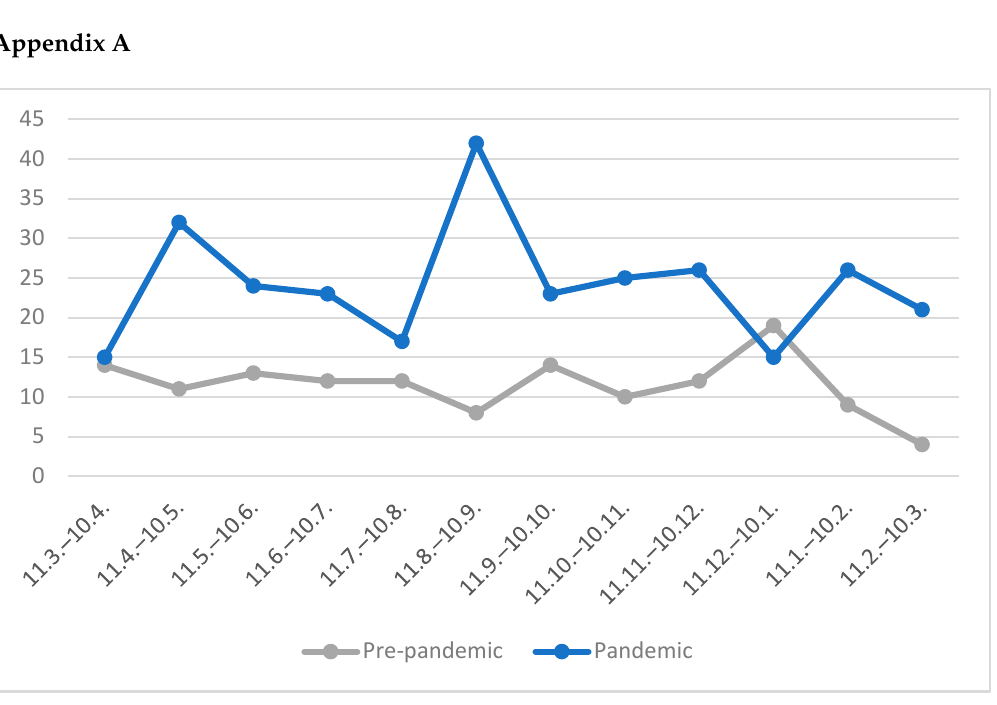
Figure A1. Frequency of trauma-related consults at University Hospital Center Osijek, Croatia, in pre-pandemic and pandemic periods. Table A1. Studies evaluating trauma during COVID-19 pandemic.